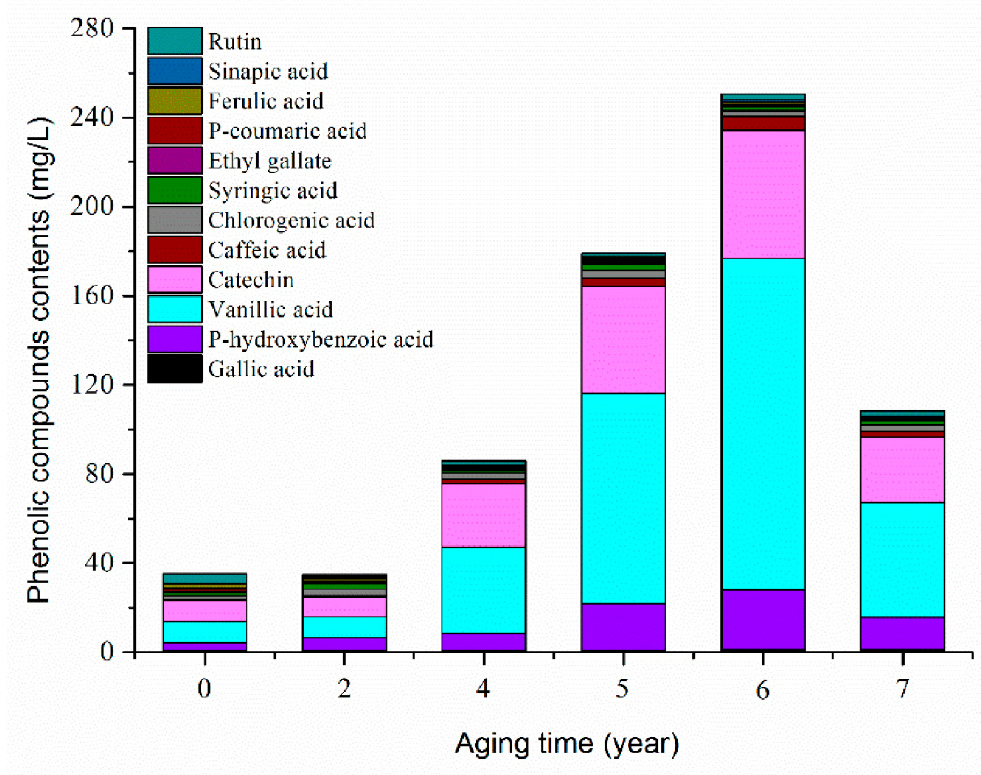
Figure 4. Variation of phenolic compound contents during the AP of ZAV.